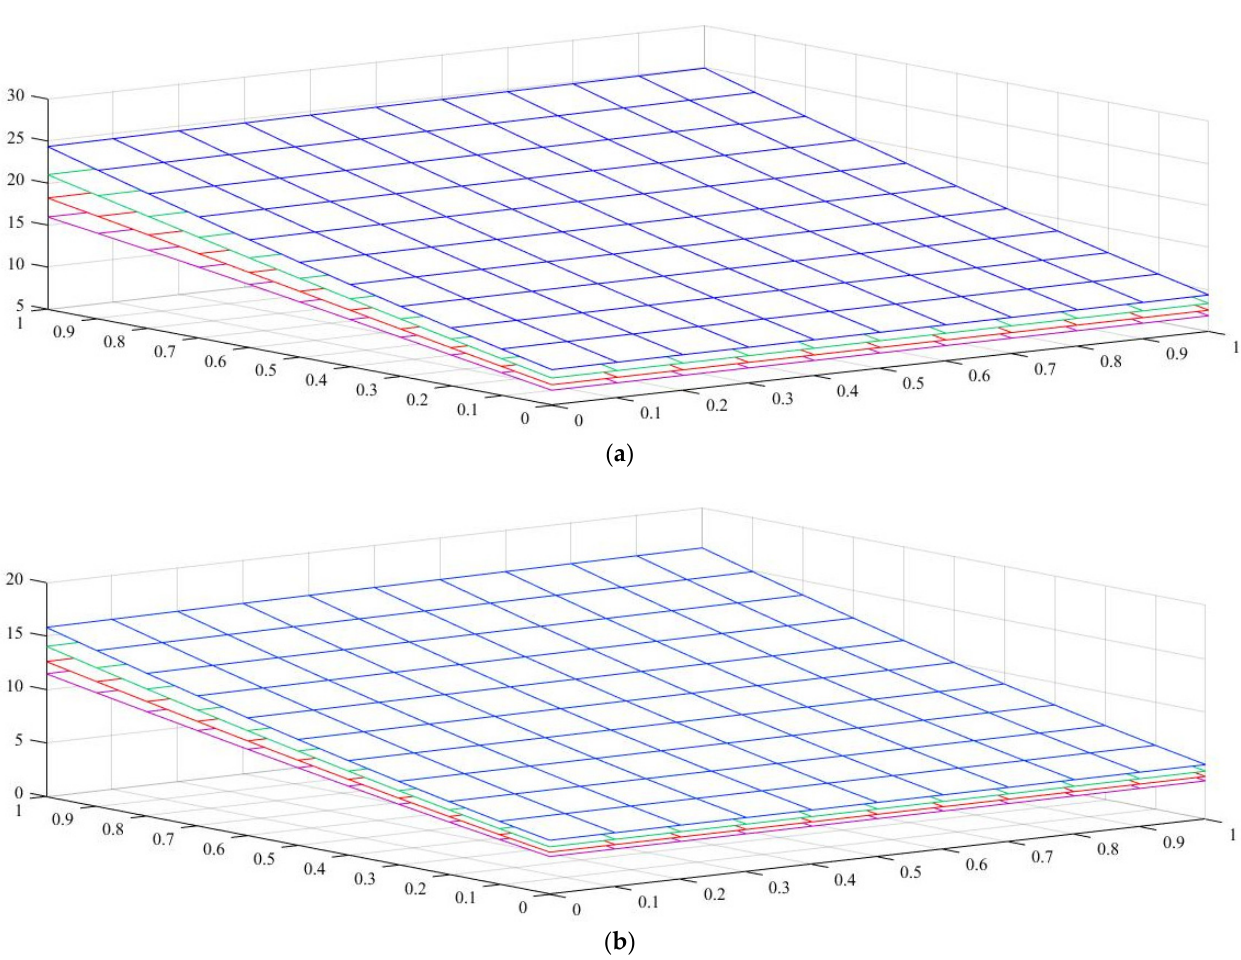
Figure 6. Variation in normalized buckling load ( P nor ) of local and nonlocal beams with a tapered I-section for various webs. Effect of the power-law exponent and tapering parameter on the normalized torsional buckling load ( P nor ) of simply supported thin-walled nanobeams with different nonlocal parameters (axial load applied on the Centroid): ( a ) pure ceramic, ( b ) AFG ( m = 1 ).